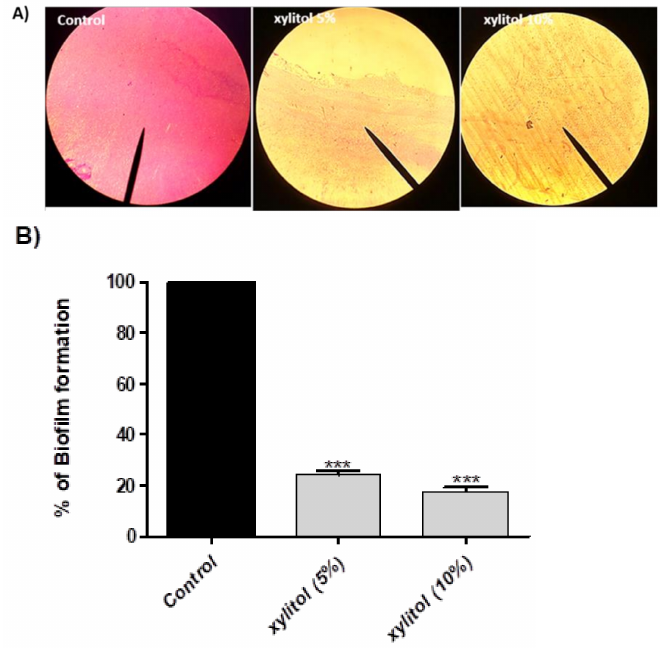
Figure 1. Biofilm inhibition of S. marcescens by xylitol. ( A ) Microscopic examination of biofilm inhibition by xylitol. Biofilm was formed on glass cover slips by xylitol-treated and untreated bacteria, and light microscopy was used for visualization. Both thickness and biofilm biomass were reduced by xylitol. ( B ) Biofilm was allowed to form on microtiter plate wells in the presence or absence of xylitol (5% and 10%) and adherent cells were stained with crystal violet, glacial acetic acid was added to dissolve the dye, and the absorbance was measured at 590 nm. The test was performed in triplicate. Biofilm formation was significantly reduced by xylitol. The data shown are the means ± standard errors. One-way ANOVA test followed by Dunnett’s Multiple Comparison test was used for statistical analysis. ***: p ≤